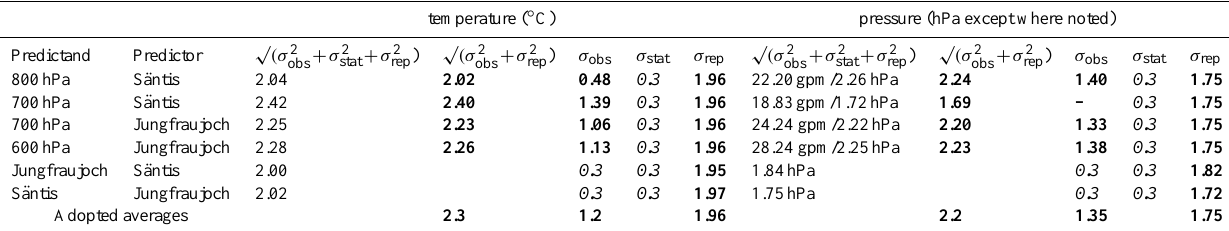
Table 1. Estimation of the error of the radiosonde observations at Freiburg i. B. based on the comparison with data from the two mountain sites S¨antis and Jungfraujoch. Bold numbers are derived from the other numbers in the table, italics refer to expert estimation, normal printing refers to the residuals calculated from regressing pairwise observations.